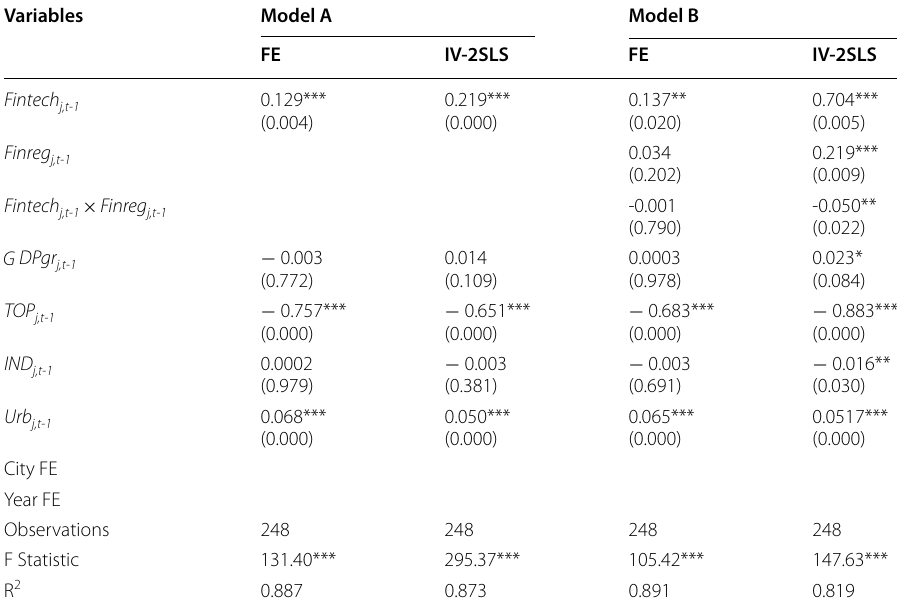
P values are shown in parentheses. Clustered standard errors at the provincial level are reported. R-square (within) is reported for FE and centered for IV-2SLS ***, **, and *, significance at the 1%, 5%, and 10% levels,